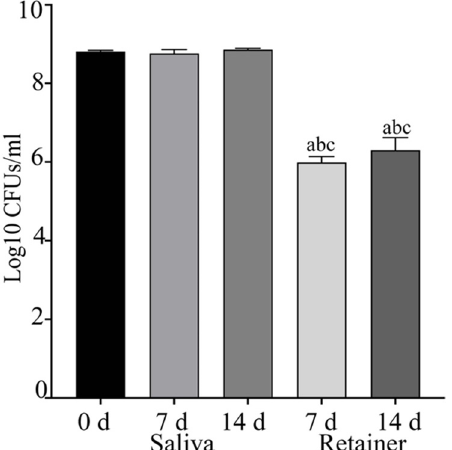
Figure 1. The determined CFUs of salivary bacteria and plaque samples were collected on the retainer surface at 7 and 14 days after retainer treatment. Salivary microbiota at 0, 7 and 14 days showed significantly increased CFUs when compared to the bacteria collected from the retainer surface at 7 and 14 days (<0.0001). a: Compared to salivary bacteria at 0 days; b: compared to salivary bacteria at 7 days, and c: compared to salivary bacteria at 14